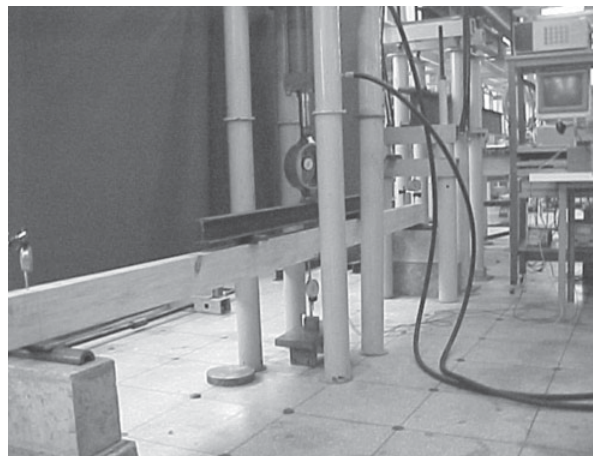
Figure 3. Bending